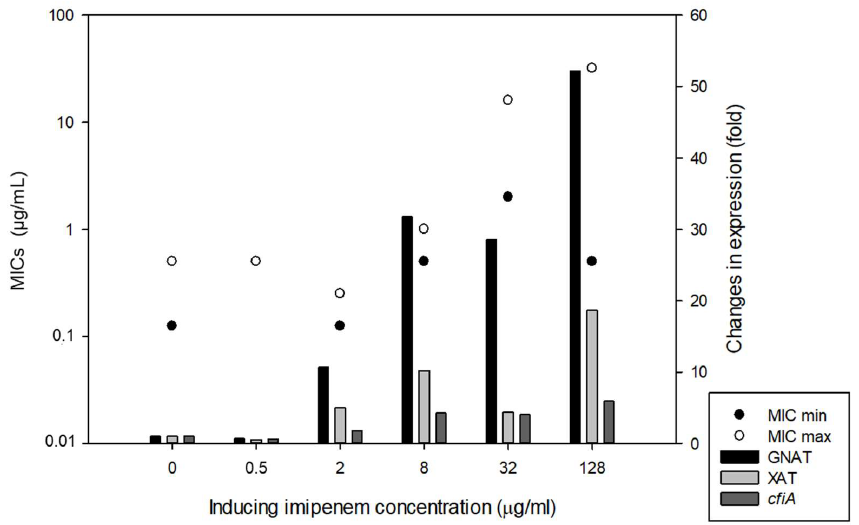
Figure 5. Induction of HR in B. fragilis 3130 with increasing imipenem concentration in the culture media (BHIS). The left-hand y axis denotes the Etest AST values (full and partial inhibition marked as minimal and maximal MICs) and right-hand y axis shows the gene expression changes for the strains in the induction experiments, respectively. strains in the induction experiments,